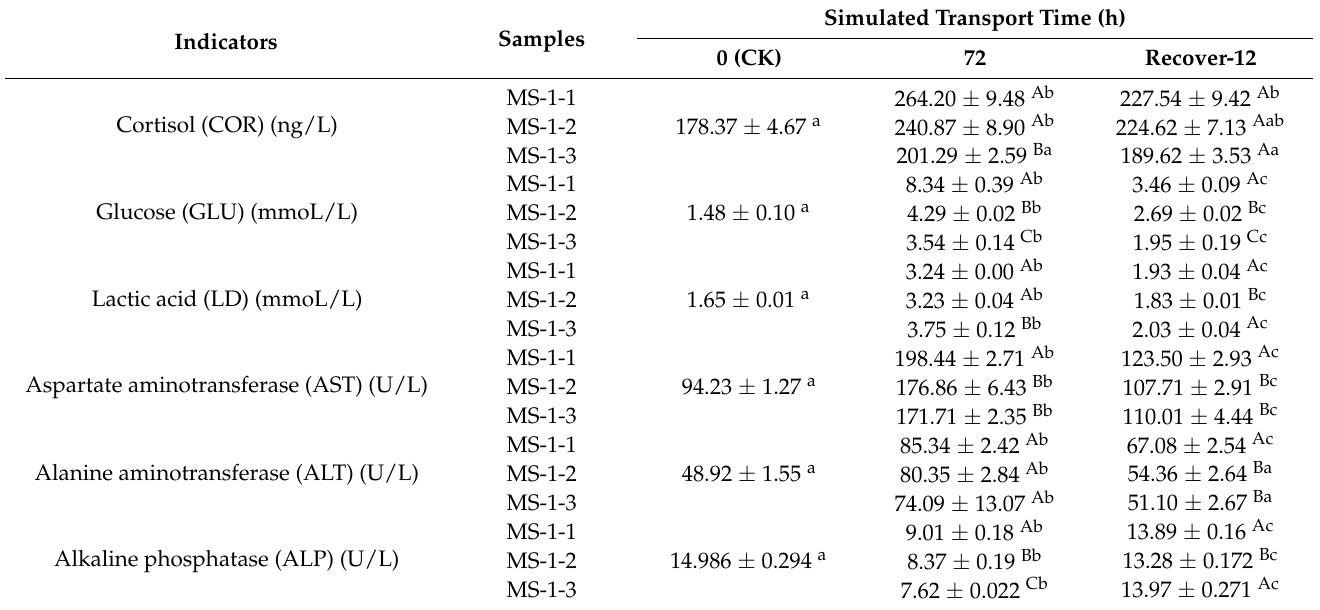
Table 2. Effects in blood biochemical stress of the sea bass before and after simulated live